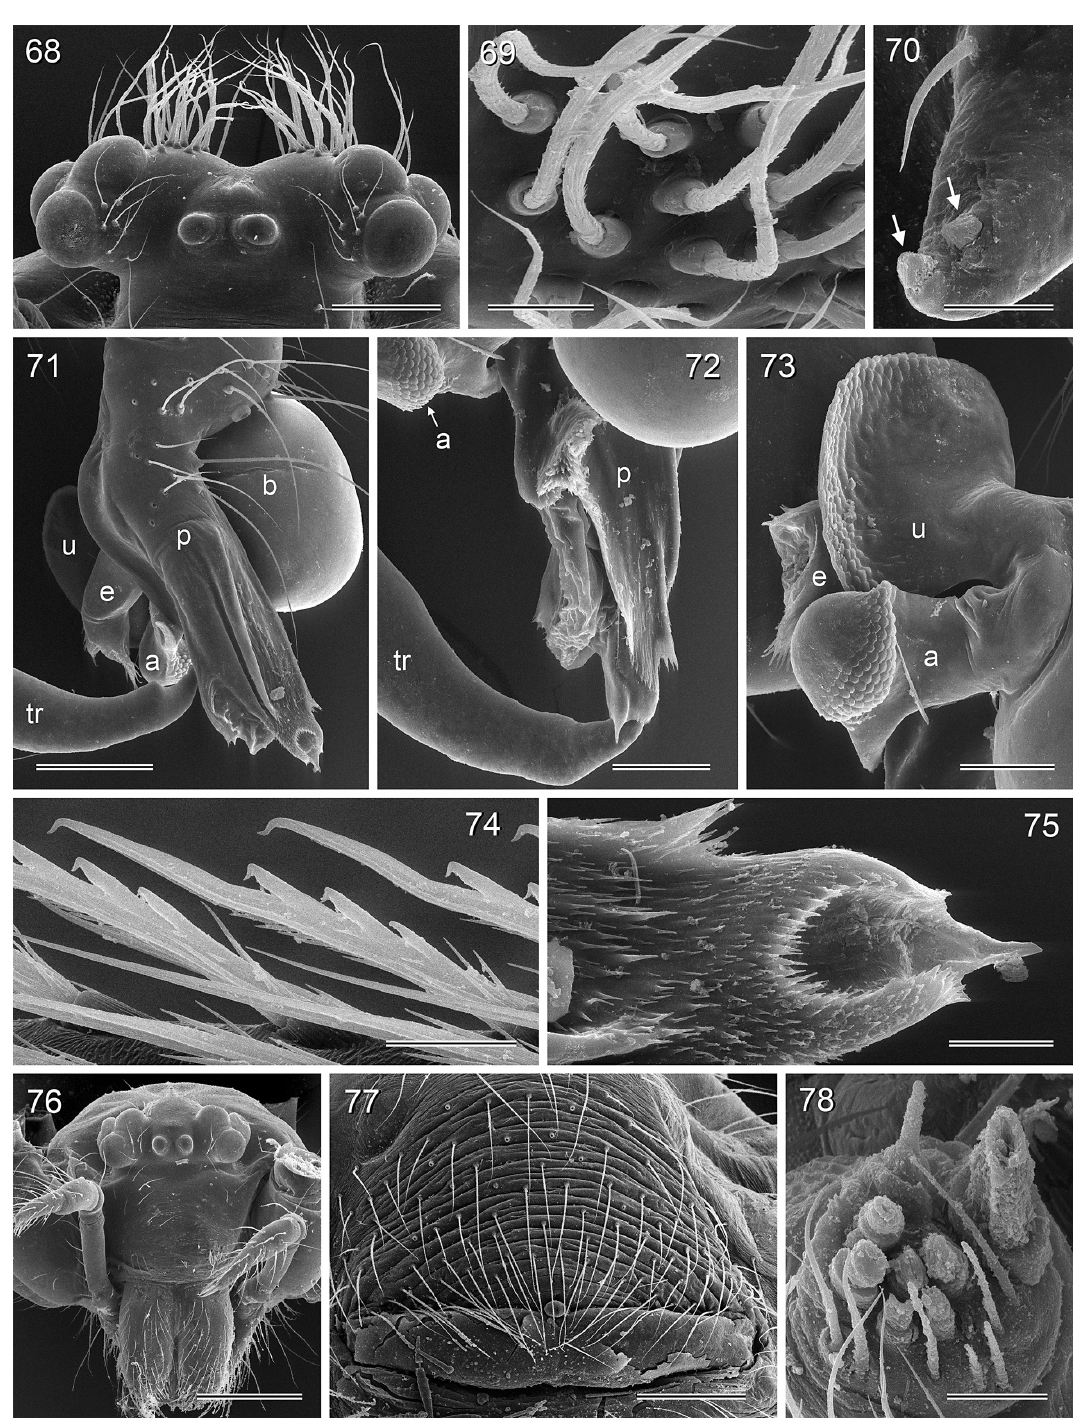
Figs 68–78. Pholcus khaolek Huber, sp. nov., ZFMK Ar 15029–30. 68 . Male ocular area, frontal view. 69 . Modified hairs between male eye triads. 70 . Male distal cheliceral apophysis (arrows point at modified hairs). 71 . Right procursus, retrolateral view. 72 . Left procursus, prolateral view. 73 . Left bulbal processes, prolateral view. 74 . Comb-hairs on male tarsus 4. 75 . Tip of right procursus, retrolateral view. 76 . Female prosoma, frontal view. 77 . Epigynum, ventral view. 78 . Male ALS. Abbreviations: a = appendix; b = genital bulb; e = embolus; p = procursus; tr = trochanter; u = uncus. Scale lines: 20 µm (70, 74, 78); 30 µm (69, 75); 80 µm (73); 100 µm (72); 200 µm (68, 71, 77); 400 µm